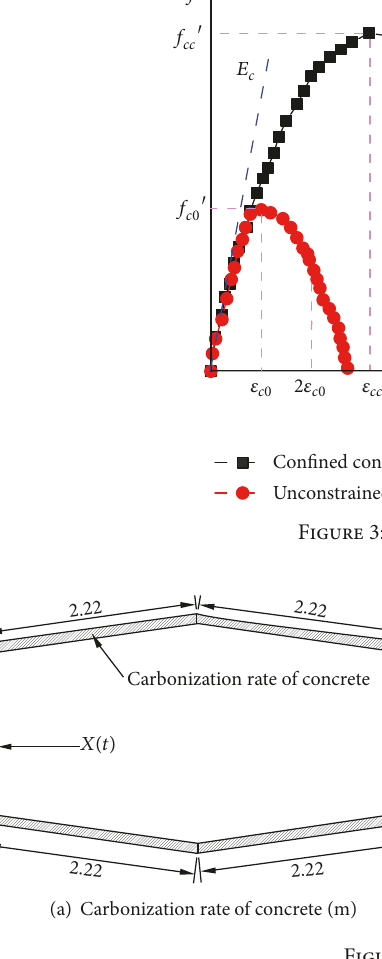
Figure 4: Section of